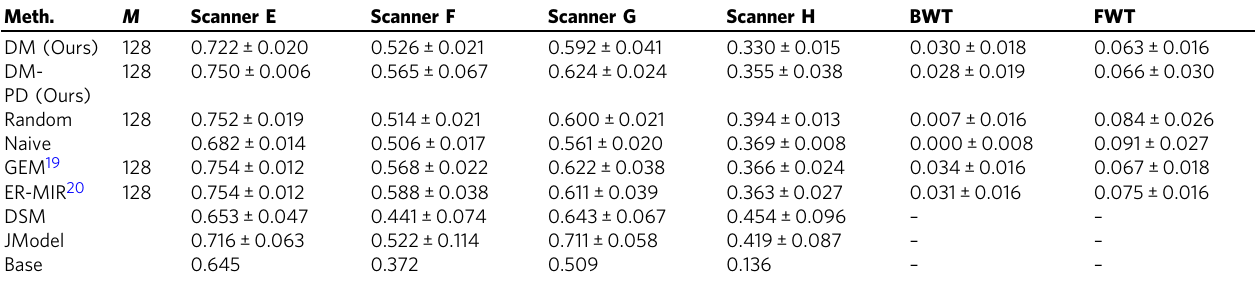
± indicates the interval over n = 5 independent runs with different seeds. Dynamic memory (DM) is compared to DM with a pseudo-domain module (DM-PD), naive continual learning, random replacement strategy (Random), domain-speci fi c models (DSM), a joint model (JModel) and using base training only (Base). In addition, GEM and ER-MIR are shown for reference, noting that they requireinformation aboutdomainmembership.For basetraining onlyone modelwastrained toavoidin fl uence of basetrainingresultsonsubsequent continualtraining, thereforenostandarddeviations are indicated. For a visual presentation of the results, see Supplementary Fig. 2.